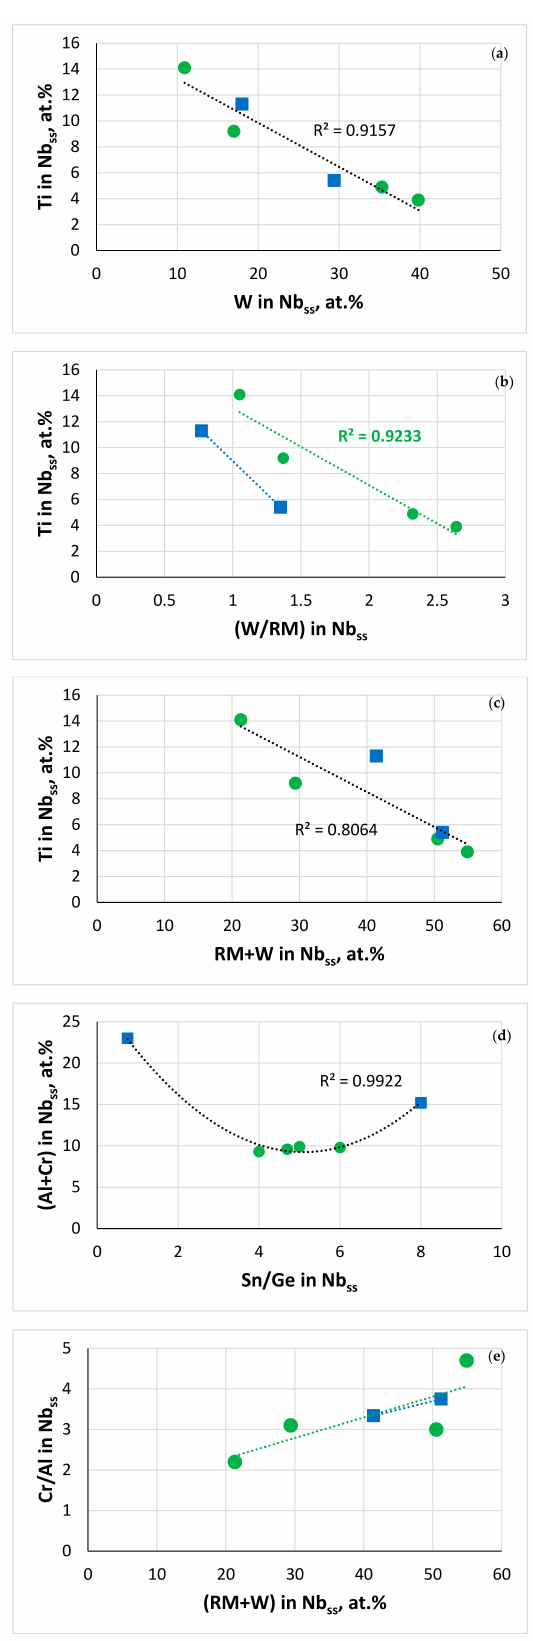
Figure 12. Data for the chemical composition of the solid solution. Squares for the alloys JZ4, JZ5, circles for Ta-containing alloys JZ1, JZ2 [46], JZ3, JZ3 + [47]. ( a ) Ti versus W in Nb ss , ( b ) Ti versus W / RM in Nb ss , ( c ) Ti versus RM + W in Nb ss , ( d ) Al + Cr in Nb ss versus Sn / Ge in Nb ss , ( e ) Cr / Al in Nb ss versus RM + W in Nb ss . RM = Mo or Ta, in ( e ) R 2 = 0.6404 for linear fit of all